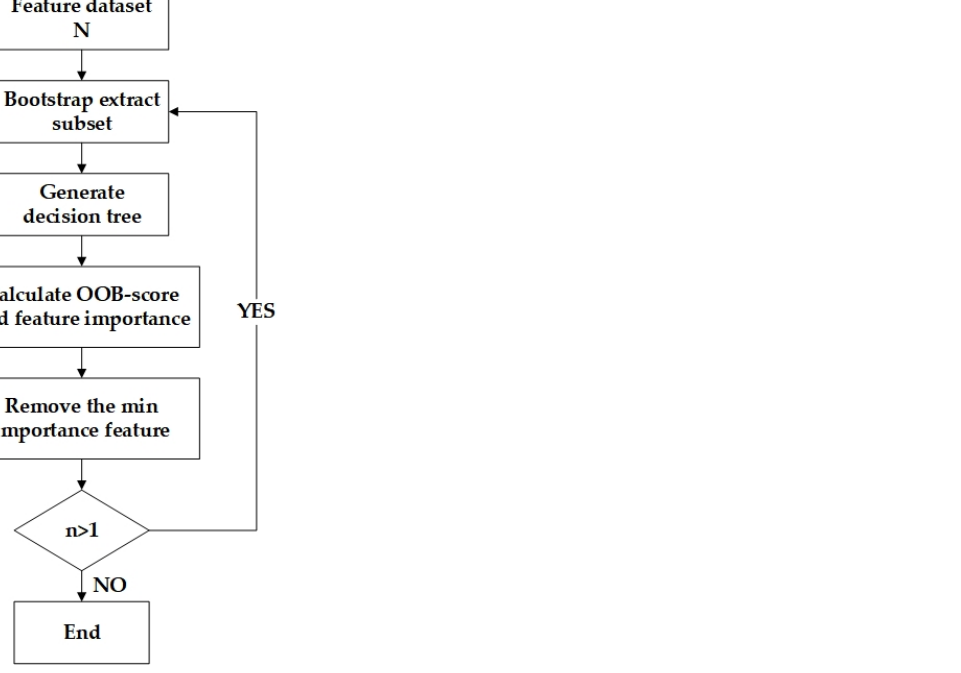
Table 4. Feature combination schemes used for classification.